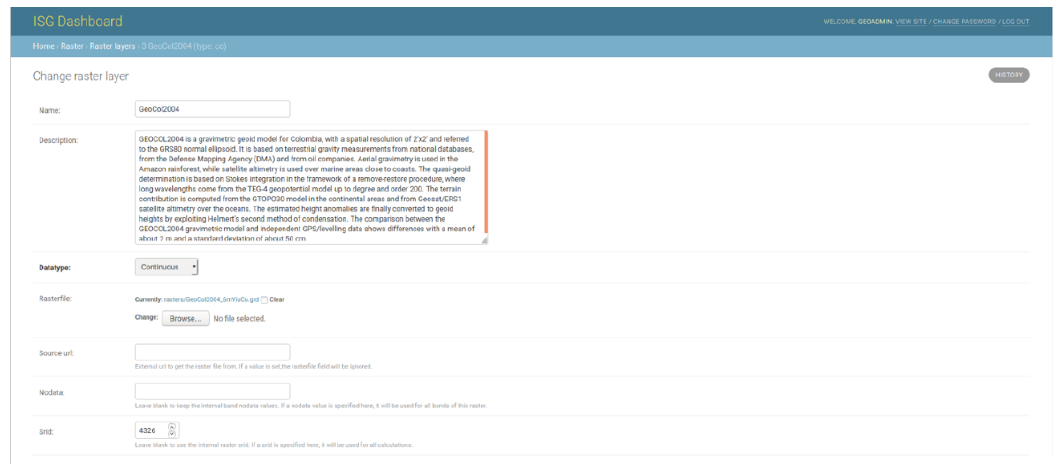
Figure 4. Geoid Model – Product Metadata – Add product (1/3)